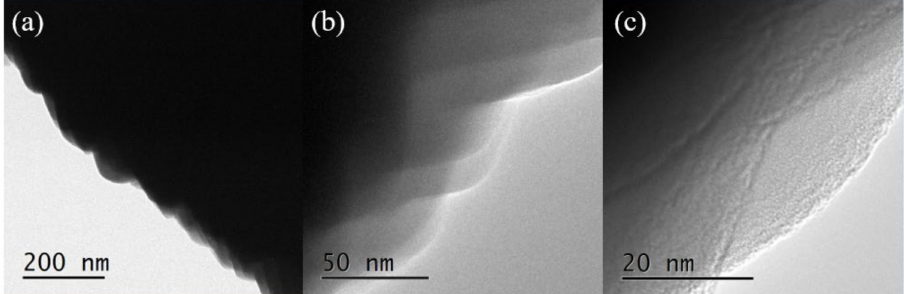
Figure 11. TEM images of sample S-12. ( a – c ) are the TEM images of sample S-12 with different magnifications and sites.